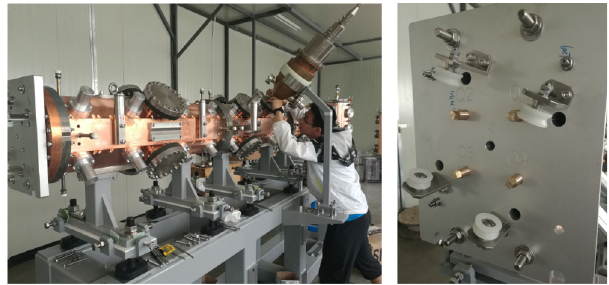
FIG. 16. Assembled XiPAF RFQ (left) and the bead-pull system (right) at one end of the RFQ for tuning.